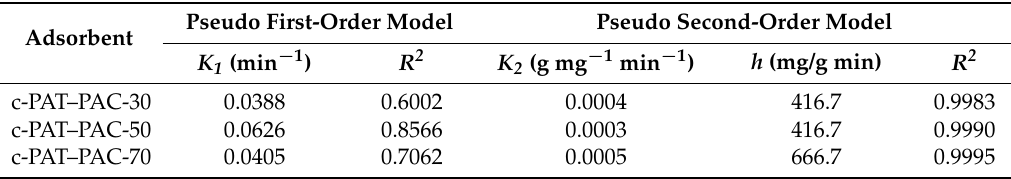
Table 3. Pseudo first-order model and pseudo second-order model constants and correlation coefficients for Ni(II) adsorption onto PAT–PAC adsorbent.